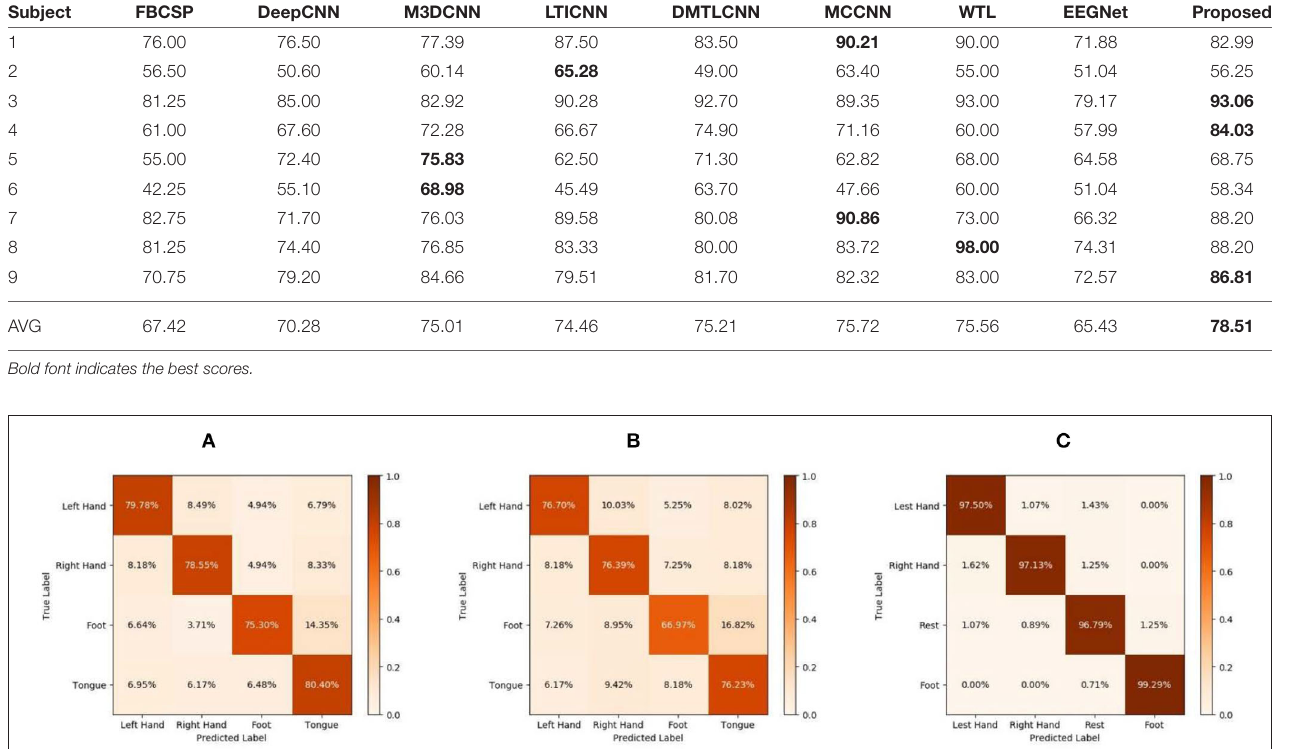
TABLE 4 | Accuracy on BCIIV2a for intra-subject classification: comparison between proposed method and other state-of-the-art methods. Accuracy (%)